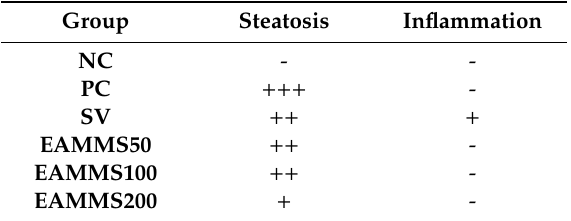
Table 5. Liver steatosis and inflammation scores in rats of di ff erent